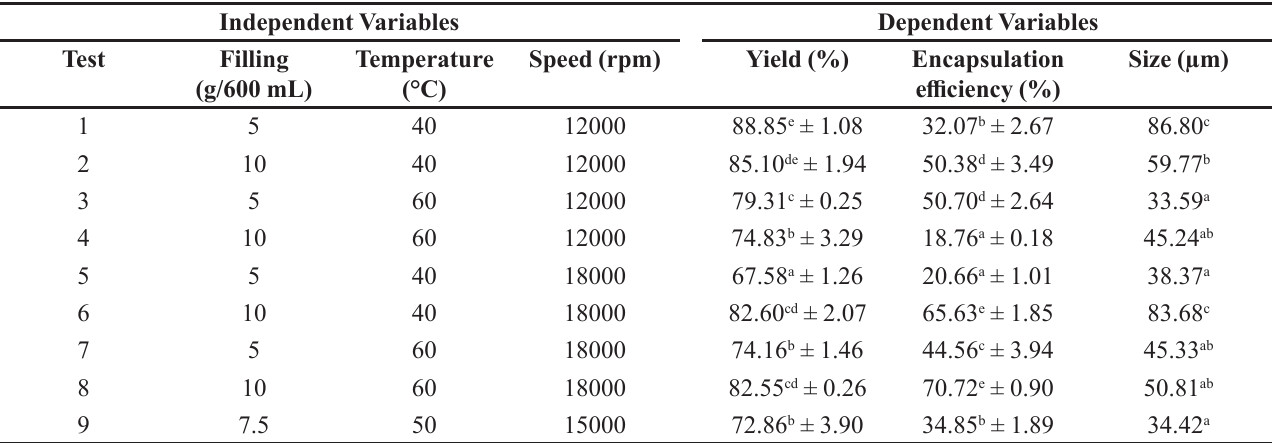
TABLE II - Effect of the amount of oil (core), temperature and homogenization speed on the yield, encapsulation efficiency and size of the bacuri pulp oil microcapsules obtained by complex